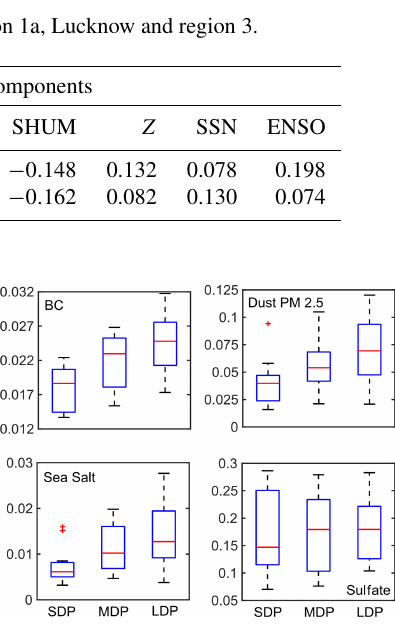
Figure 4. Frequency distribution analysis results of various control- ling factors behind DDF evolution for various types of dry phase lengths over Lucknow corresponding to five aerosol components such as BC, dust PM 2 . 5 , OC, sea salt and